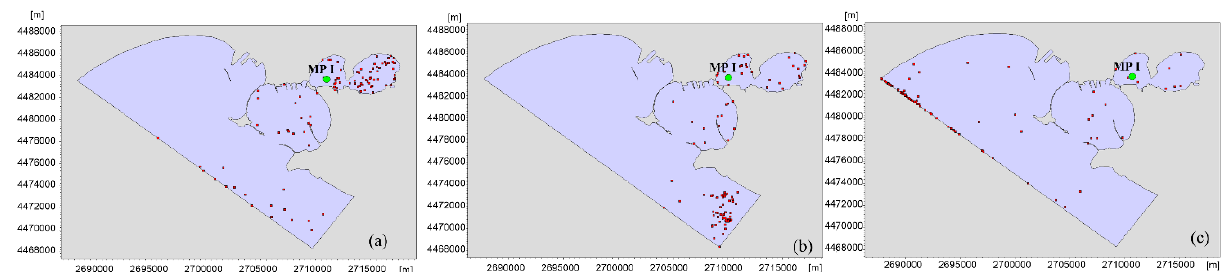
Figure 16. Percentage PT4 (MPI) — the cloud of particles: ( a ) 30 days after release; ( b ) 60 days after release; ( c ) 90 days after release at surface layer.